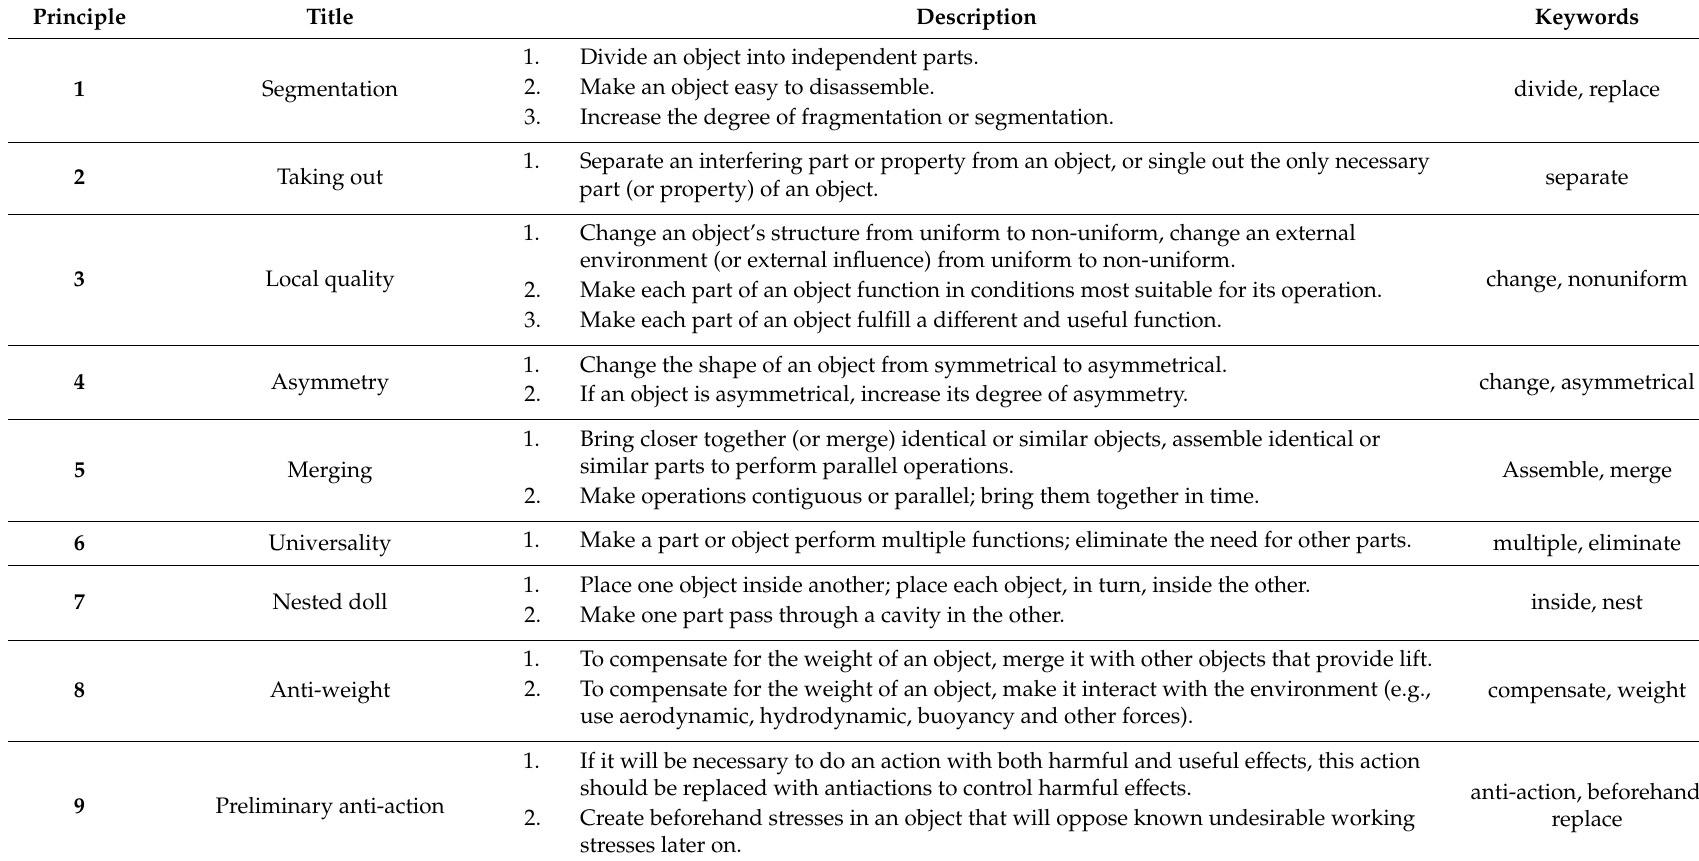
Table A3. List of TRIZ inventive